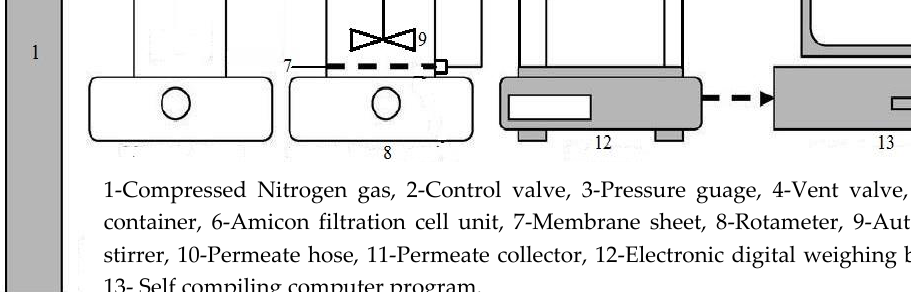
Figure 1. Schematic process of the dead-end filtration system setup.